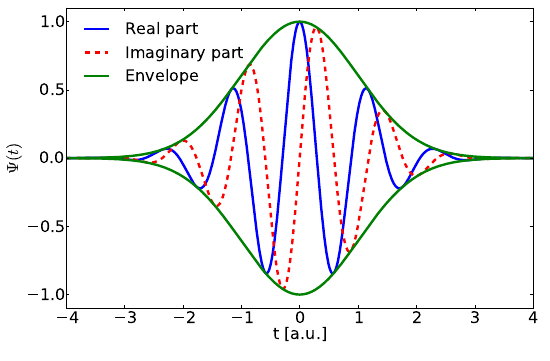
Figure 2 . The Morlet wavelet at its smallest internal fre- quency ω 0 = 5 . 336 . The oscillations o the real R ( t ) and imag- inary part I ( t ) of the complex-valued wavelet are enclosed in the positive and negative modulus of Ψ ( t )